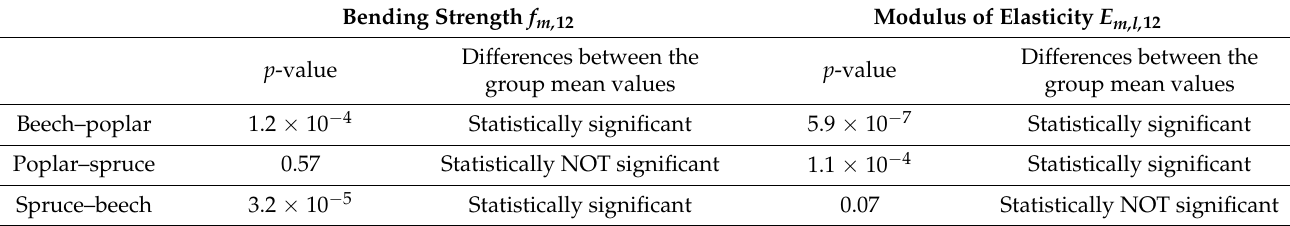
Table 8. Dunn’s test